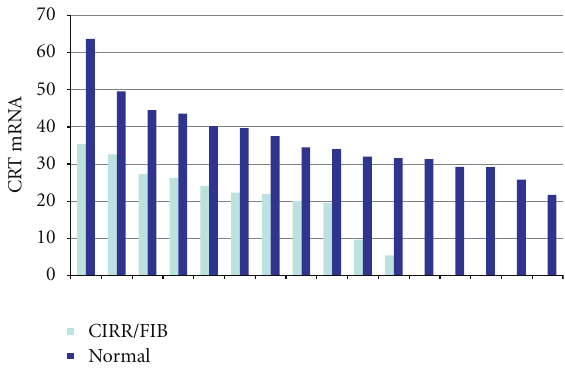
Figure 1: CRT expression and HH-related symptoms. CRT mRNA expression in PBMCs from HFE C282Y homozygous patients. Each bar represents an individual subject, ordered by CRT level and divided according to the presence (light blue bars) or absence (dark blue bars) of cirrhosis/fibrosis (CIRR/FIB), modified by Porto from original data from Pinto et al., 2008